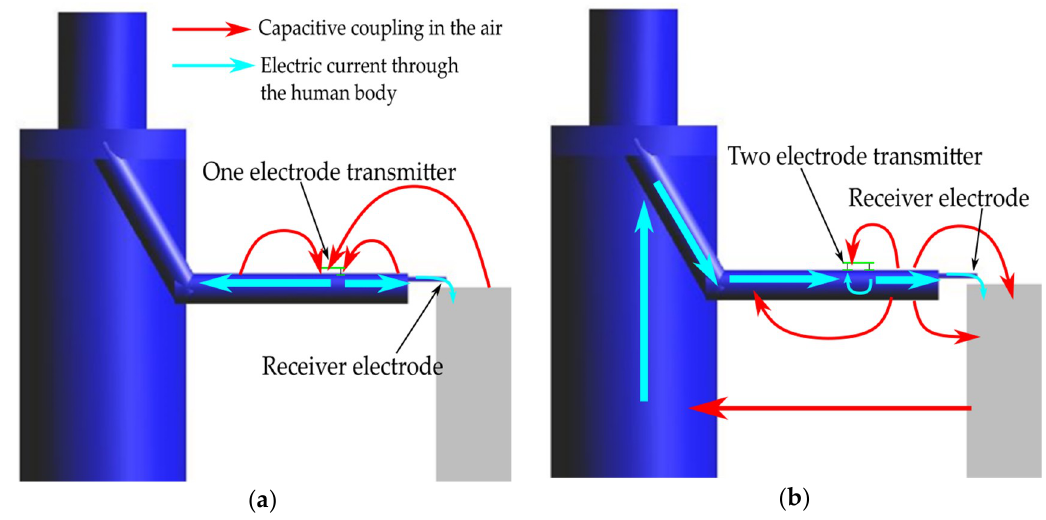
Figure 8. Transmission signal path: ( a ) Signal path for the one-electrode transmitter. ( b ) Signal path for the two-electrode transmitter.